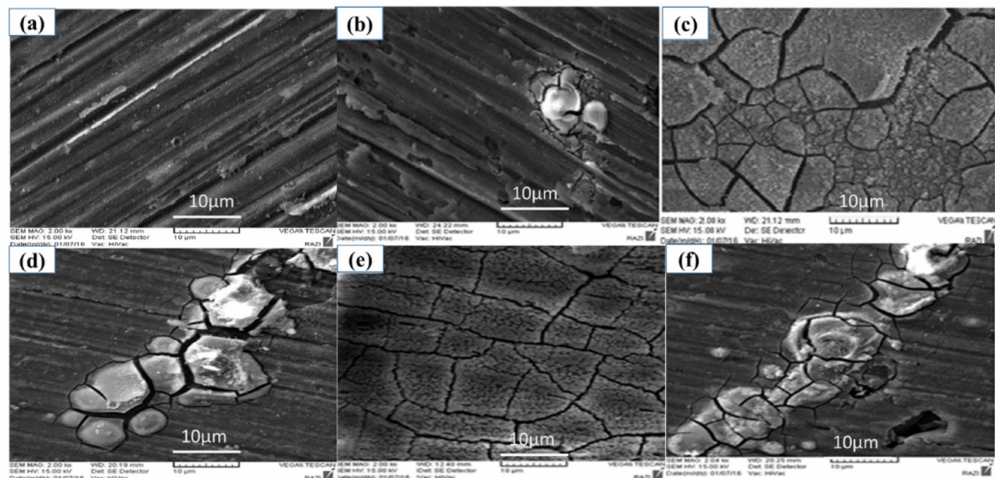
Figure 6. SEM micrographs of different cerium coated and uncoated AA5083 prepared by various pretreatment methods ( a ) uncoated AA5083, ( b ) A, ( c ) B, ( d ) C, ( e ) D, and ( f )